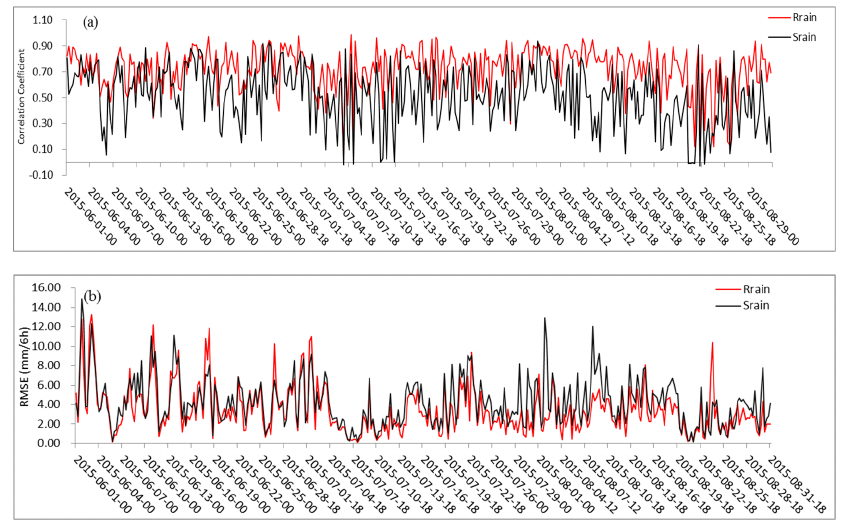
Figure 5. Time series of ( a ) correlation coefficient and ( b ) RMSE (mm/6 h) of radar (Rrain, red line) and satellite (Srain, black line) precipitation products at the 6-h temporal interval from June–August 2015.